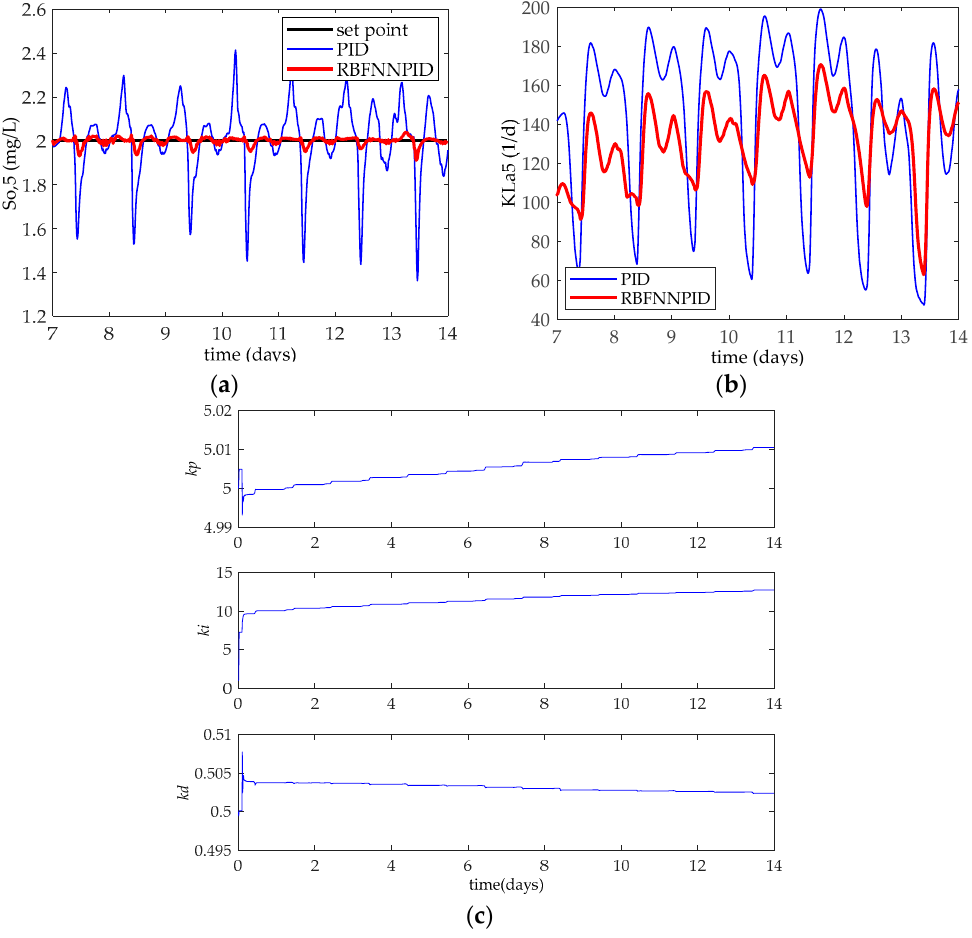
Figure 6. Comparison results of the tracking performance (dry weather): ( a ) DO concentration in the fifth tank; ( b ) Dynamic changes of the manipulated variable K L a 5 ; ( c ) Dynamic adaptive adjustments of the three parameters kp , ki , kd of RBFNNPID algorithm.